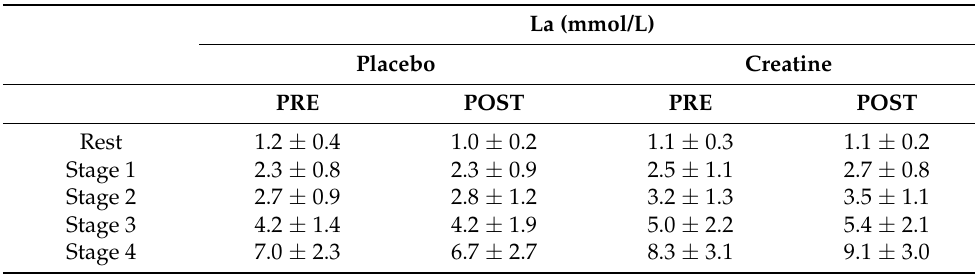
Table 1. Blood lactate (La) at rest and at the four stages of the submaximal test, pre- and post- supplementation in each group.